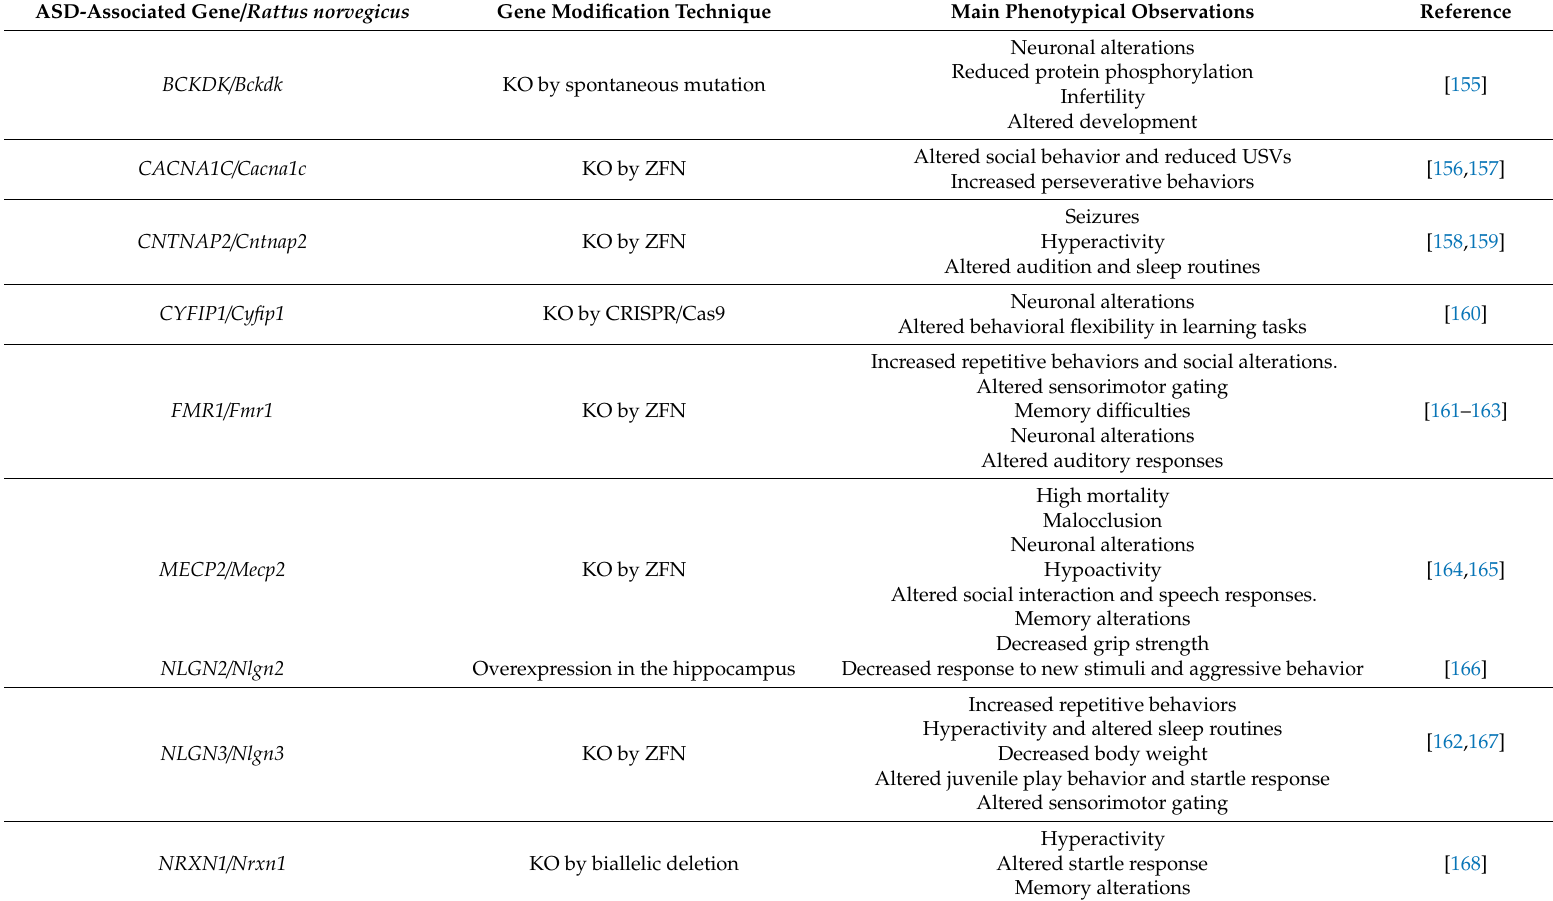
Table 6. Phenotype observed in Rattus norvegicus models of ASD-associated genes. The table includes the developed models to study the function and implication in ASD of genes classified with score 1 (high confidence) or gene score 2 (strong candidate) in the SFARI Gene database [20,21]. In the cases in which several models have been developed, the phenotype column only includes their common